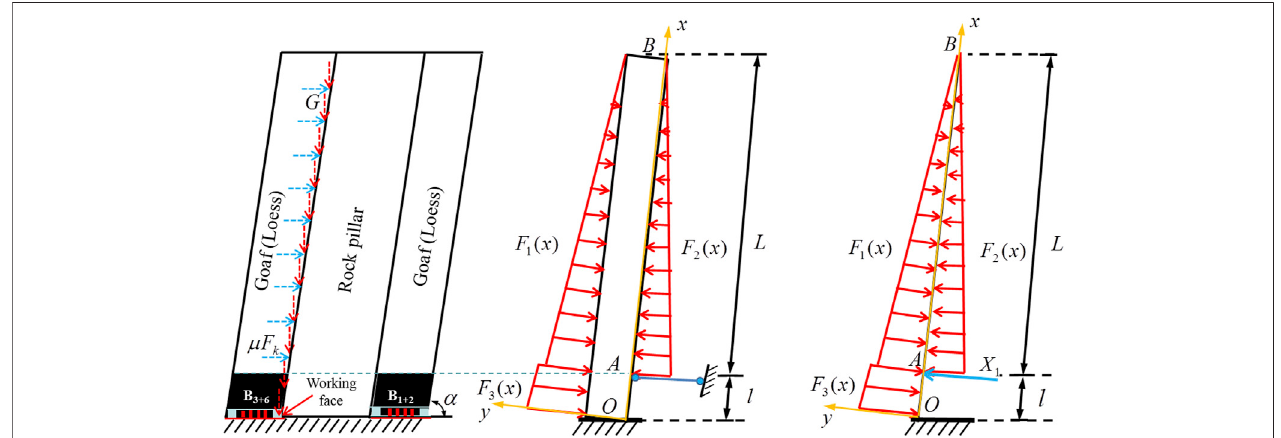
FIGURE 3 | Mechanical model of the rock